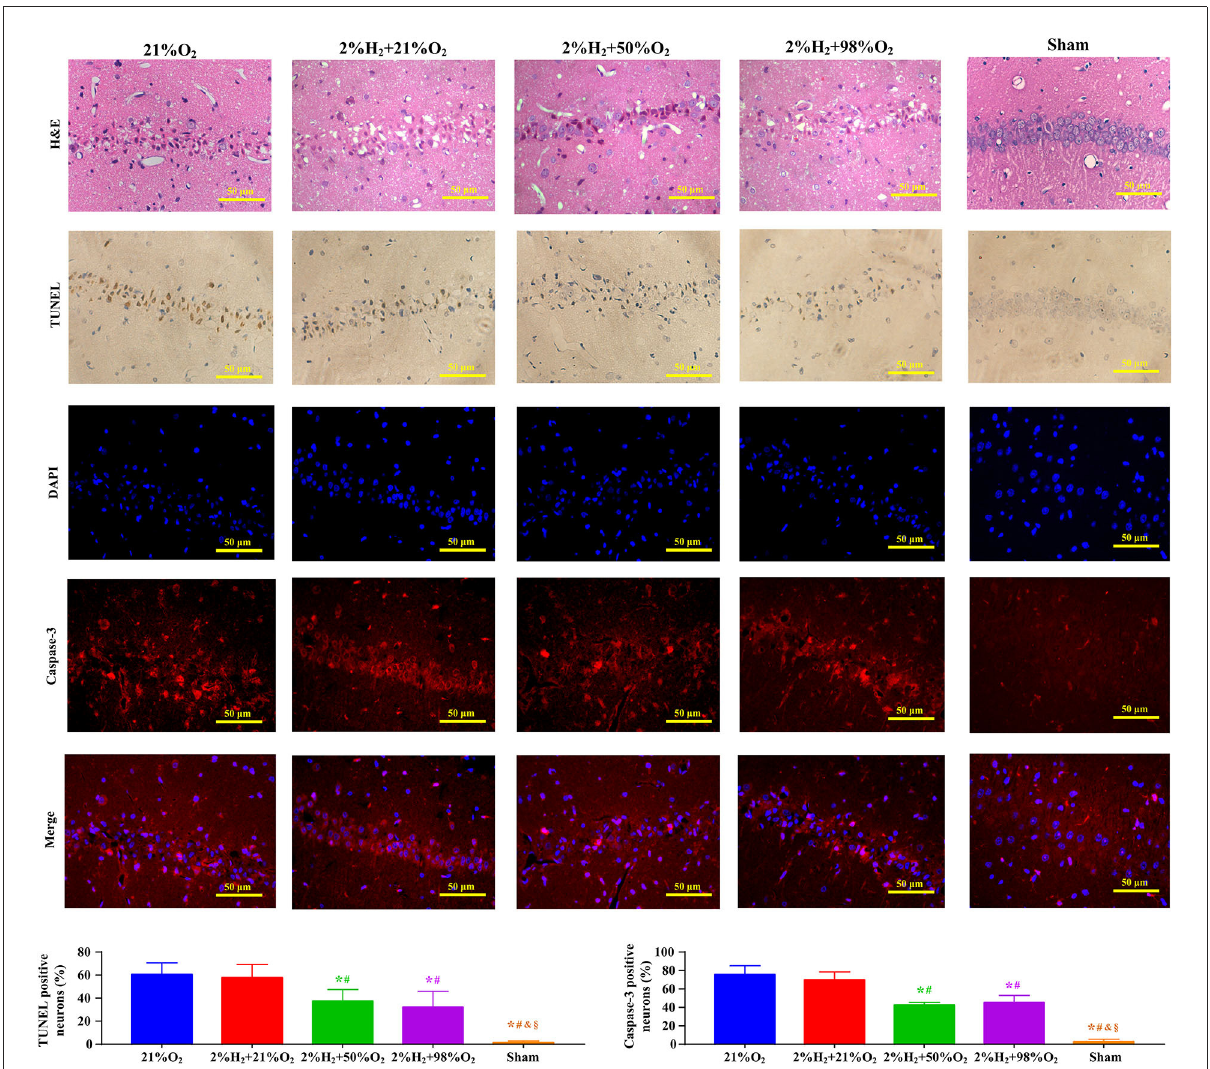
FIGURE2 Representative micrographs of the hematoxylin and eosin (H&E), terminal deoxynucleotidyl transferase-mediated deoxyuridine triphosphate nick end labeling (TUNEL), 4 ′ ,6-diamidino-2-phenylindole (DAPI), Caspase-3 stained neurons in the CA1 hippocampus region, ratio of TUNEL positive neurons, and ratio of Caspase-3 positive neurons at 96h after resuscitation in animals under normothermia. * p < 0.05 vs. 21%O 2 group; # p < 0.05 vs. 2%H 2 + 21%O 2 group; & p < 0.05 vs. 2%H 2 + 50%O 2 group; § p < 0.05 vs. 2%H 2 + 98%O 2